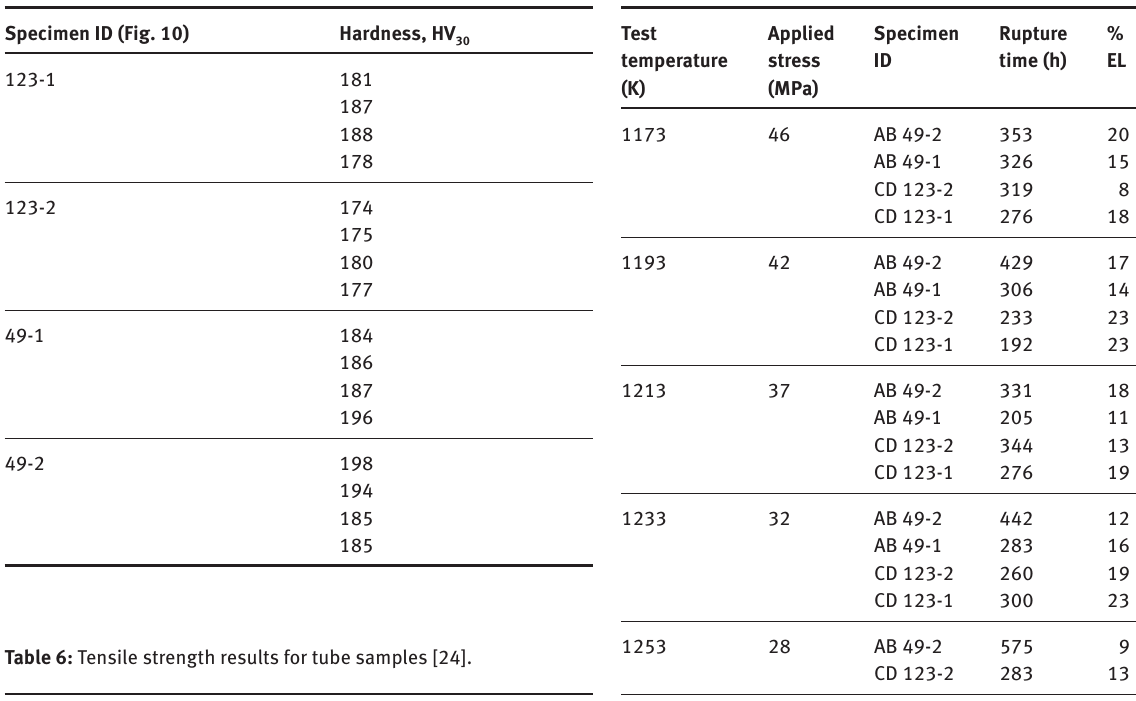
Table 6: Tensile strength results for tube samples [24]. Test temperature